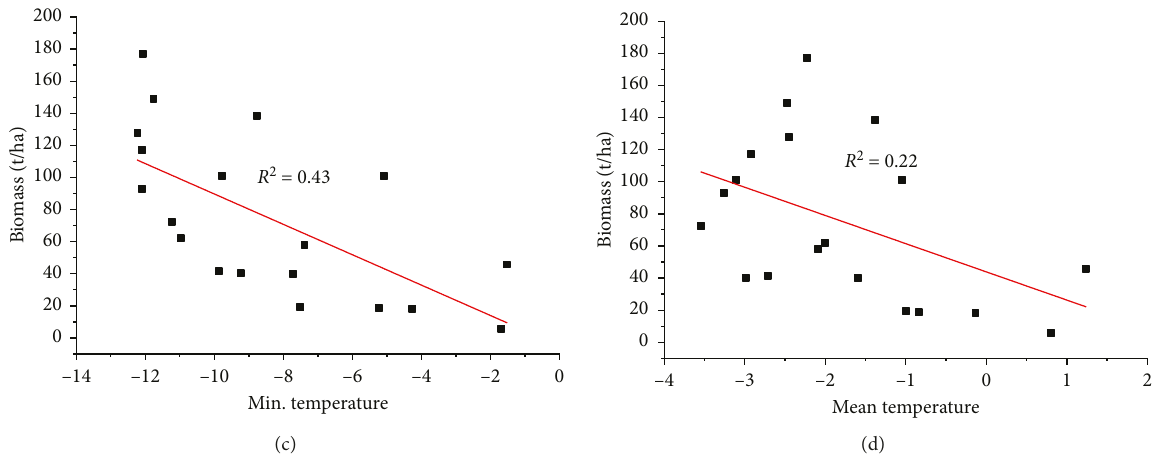
Figure 4: Relationship between Larix gmelinii stem biomass (SB) with < 470mm (PPT) along with climatic gradients from 1950 to 2016: